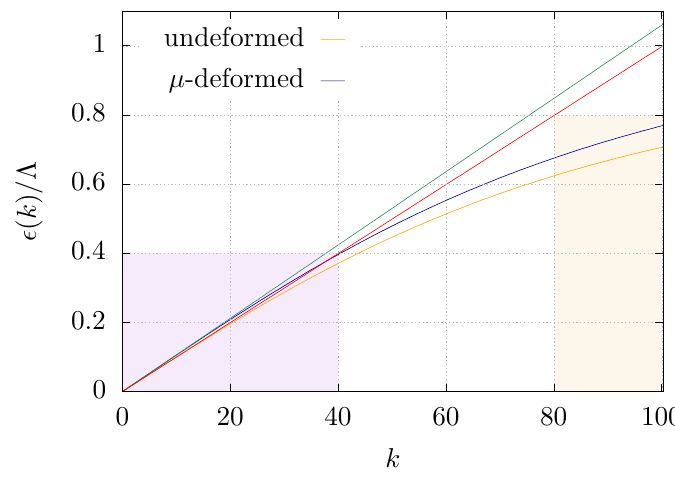
Figure 1 . Dispersion relation (cid:15) ( k ) normalized with respect to the cutoff Λ in eq. (2.22) for the T ¯ T -deformed theory vs. the undeformed one. The straight lines represent the dispersion relation in eq. (2.26) for the deformed (green) vs. the undeformed (red) theory. The limit k (cid:28) Λ is represented as a purple shadowed region while the UV limit where the deformation acts is marked by the yellow- shadowed region. To perform this plot we took µ = 10 − 4 and Λ = 1 /